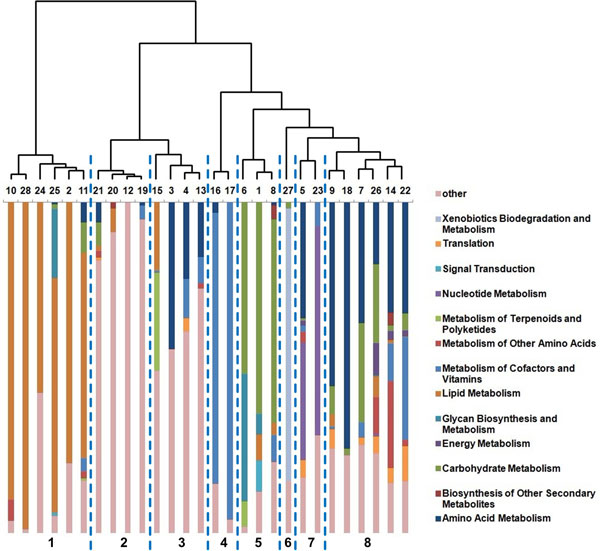
Hierarchical clustering for modules. Each rectangle represents a module and the number above is the module's index. Each color denotes a biological process according to the KEGG pathway classification and its area in one rectangle reflects the proportion of the corresponding biological process in this module. The biological processes named "other" are reactions that do not exist in any KEGG human pathway. The dotted lines classified the 28 modules into 8 clusters according to the hierarchical tree in this figure.